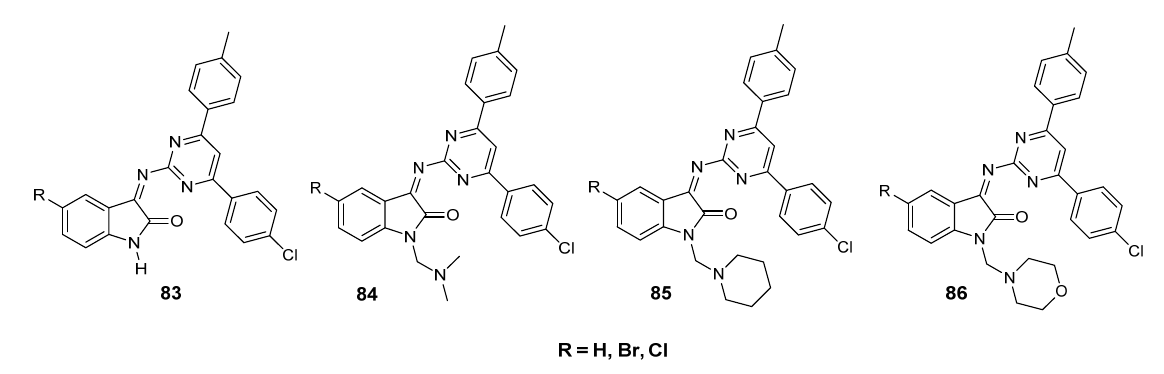
Figure 10. Isatin derived Schiff bases.